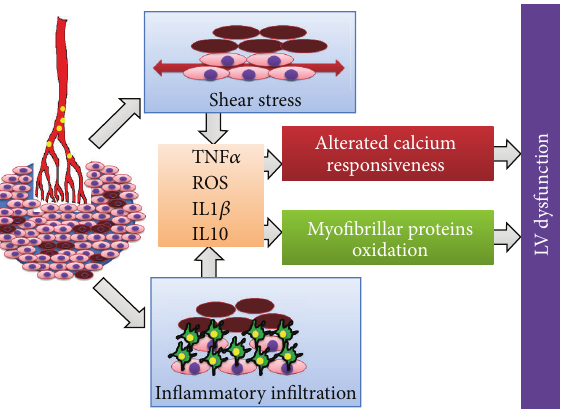
Figure 3: Mechanisms leading to left ventricular impairment after distal embolisation. Inflammatory responseand shear stressat theinterface between embolised and non embolised myocardium trigger the cytokines cascade which leads to myofibrillar proteins oxidation and reduced calcium responsiveness, underlying left ventricular dysfunction after distal